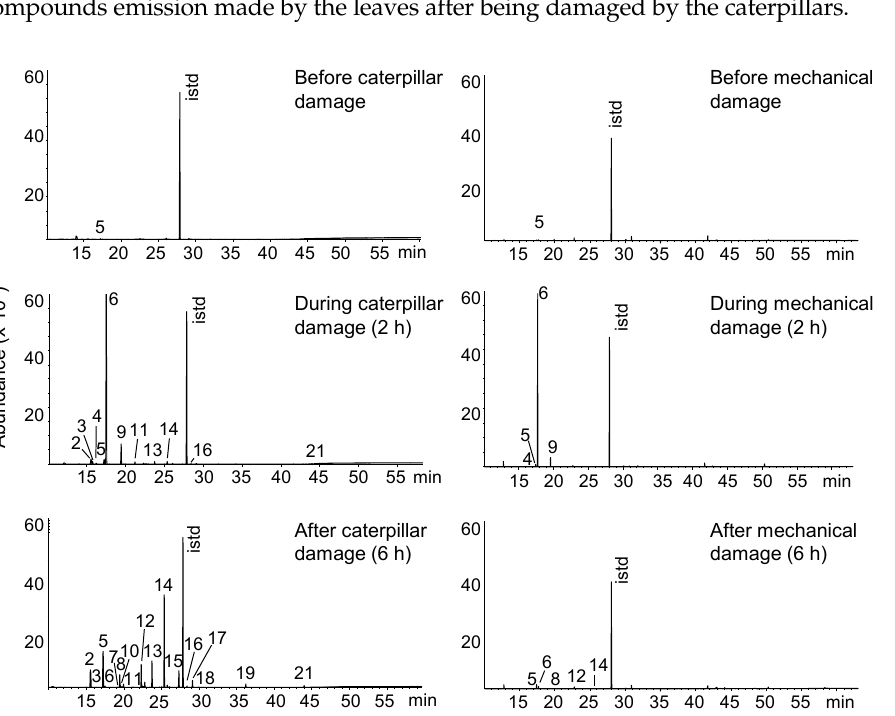
Figure 3. Volatile compounds released by C . nitens leaves after attack by U . ornatrix caterpillars or after mechanical damage. Peak identification appears in Table 1; istd, methyl undecanoate.